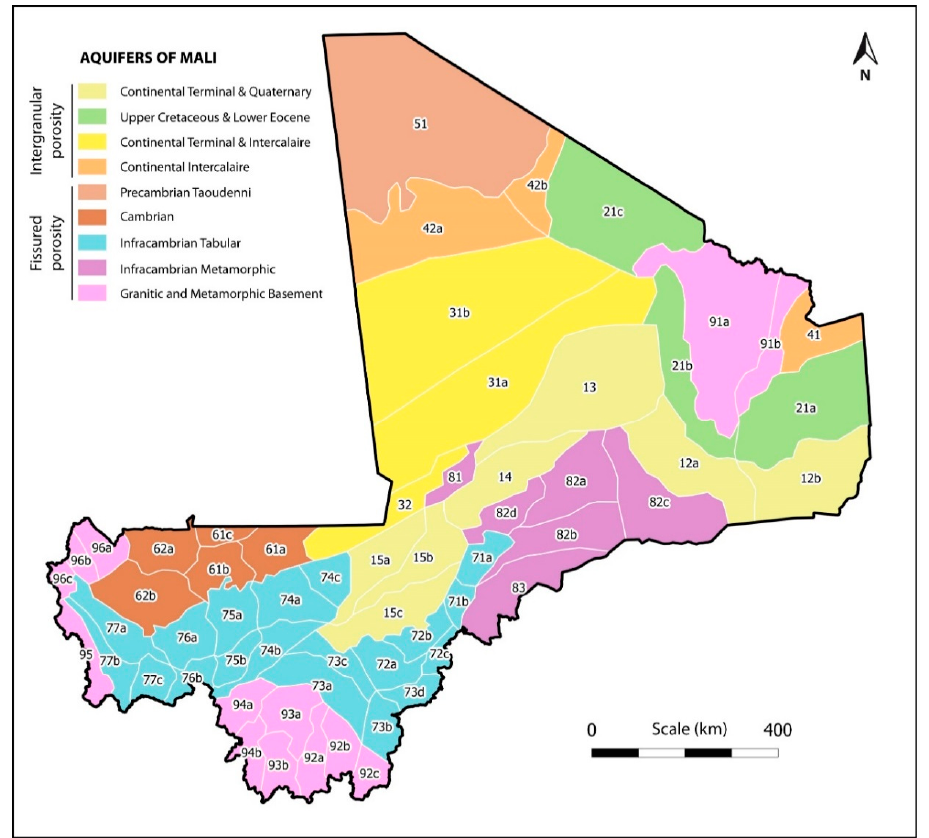
Figure 3. Main hydrogeological units of Mali (adapted from the map by the Département de la Coopération Technique pour le Développement du Mali [26]). Numbers represent the official code of each aquifer sector as outlined in Table 1.